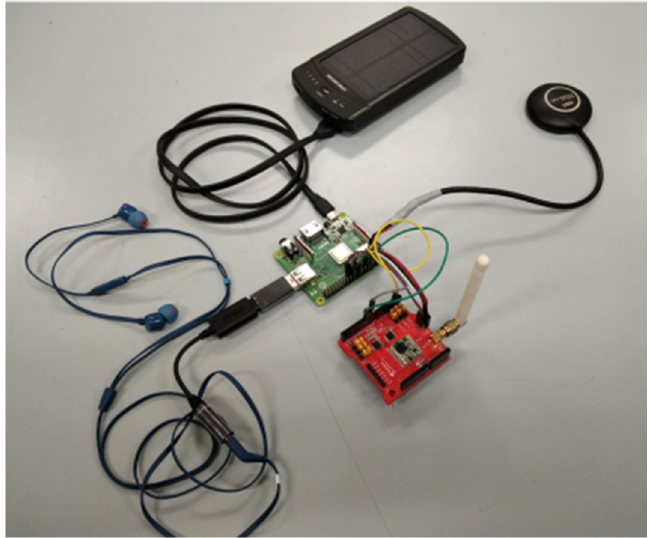
Figure 6. An indicative arrangement allowing for voice command functionality and GPS position- ing using a raspberry pi 3 model A+, a LoRa Dragino radio module, and the ASUS AI noise-can- celing stick plus a headset. This system variant is tailored for accompanying the operator (i.e., the farmer).